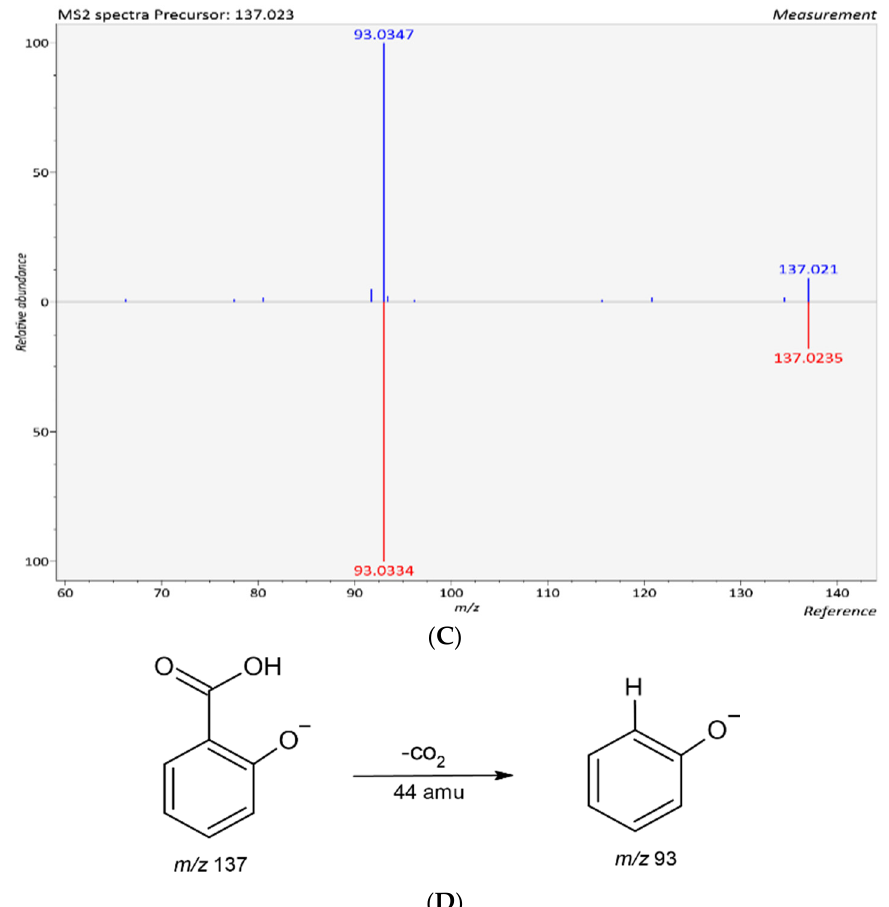
Figure 1. LC-MS/MS screening of 2-hydroxybenzoic acid (compound 8 ). A chromatogram ( A ) and a mass spectrum ( B ) of 2-hydroxybenzoic acid are presented, which was identified from thyme (sample code 14N) in negative mode while MS/MS product ion spectra ( C ) was confirmed through online LC-MS library and database; ( D ) a possible fragmentation pattern of 2-hydroxybenzoic acid in negative mode is also presented with the loss of CO 2 (44 amu).